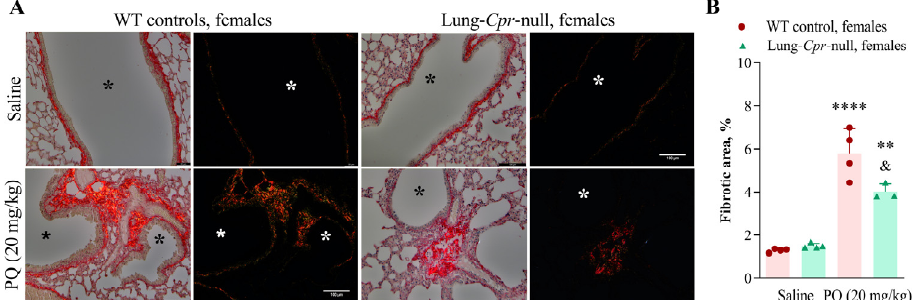
Figure 4. PQ-induced collagen deposition in the lungs of female mice. Three- to four-month-old female lung- Cpr -null and WT control littermates received a single intraperitoneal injection of saline or 20 mg/kg PQ. The lungs were collected on day 15 after the injection, embedded in paraffin and stained with picrosirius red. The deposition of collagen fibers was evaluated in seven to eight microscopic fields per lung section, at ×200 magnification, using brightfield ( left ) and polarized light ( right ) microscopy. ( A ) Representative images of lung sections with deposited collagen are shown (*, airway; scale bar is 100 µm). ( B ) The fibrotic lesion area (%) was quantified as described in Material and Methods . Results represent means ± SD ( n = 3–4 per group). & , p < 0.05, by mouse genotype; **, p < 0.01, ****, p < 0.0001, by exposure (one-way ANOVA followed by Bonferroni’s test for multiple comparisons).